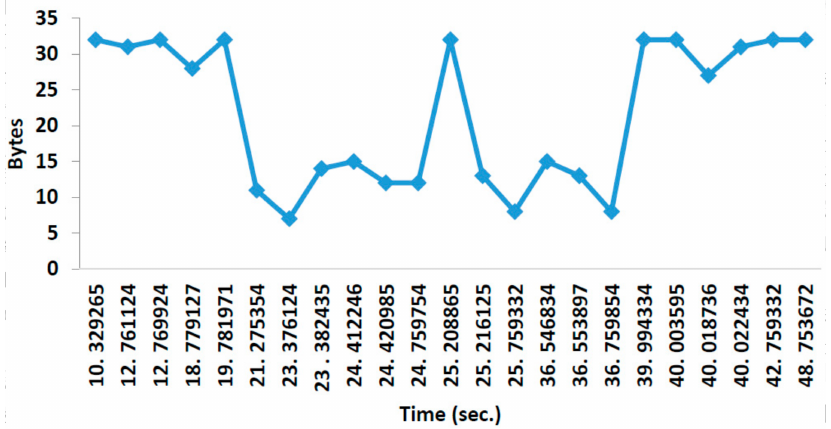
Figure 9. Network traffic, point to